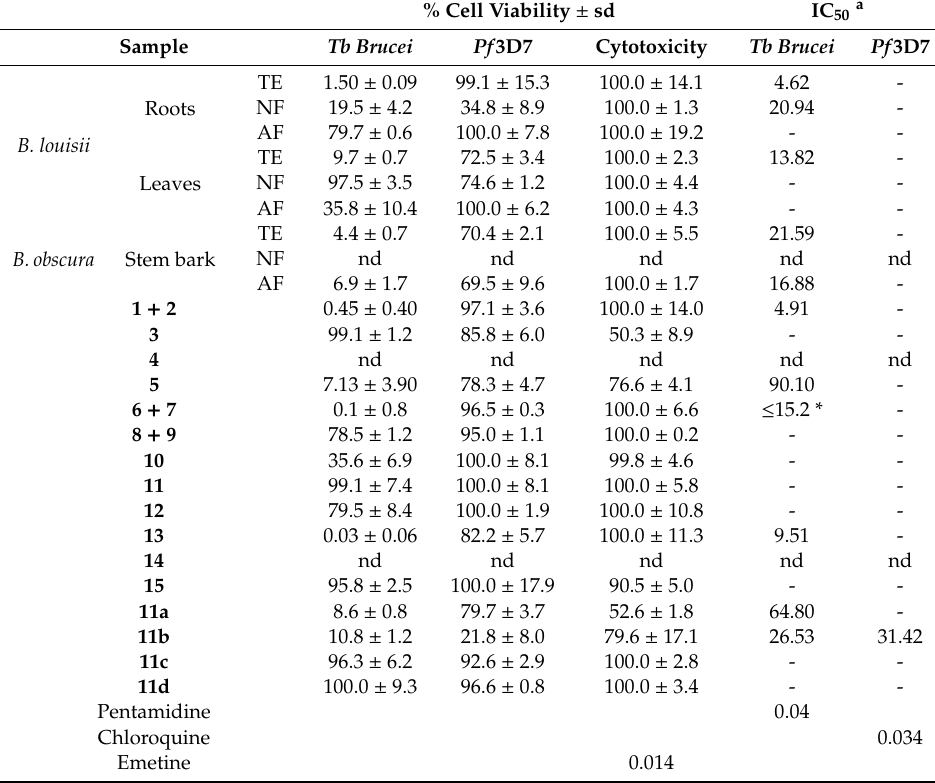
Table 5. Antimalarial, antitrypanosmal activities, and cytotoxicity of extracts and isolated